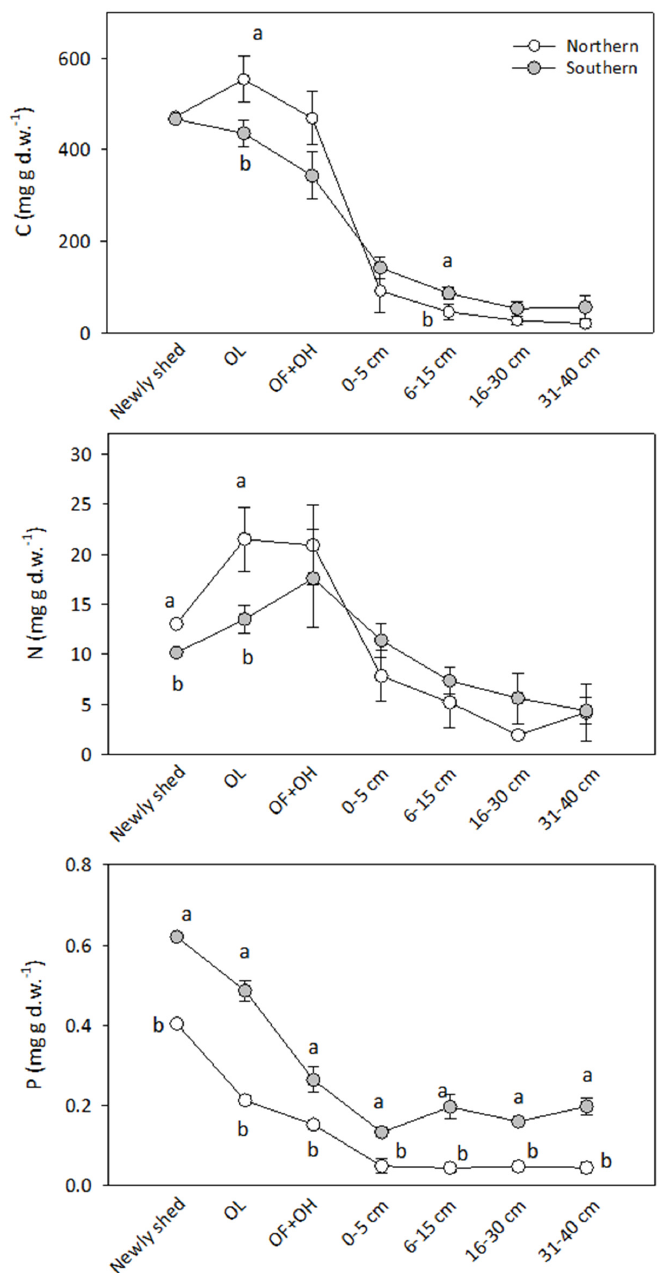
Figure 1. Nutrient concentrations in newly ‐ shed leaves, floor litter (OL and OF + OH layers) and mineral soil at different depths in a northern and a southern beech forest. Values are means ± standard error; n = 36 (6 sampling plots, 2 sampling seasons, 3 replicate analyses). Different lower ‐ case letters indicate significant differences between sites ( t ‐ test; overall significance level = 0.05).